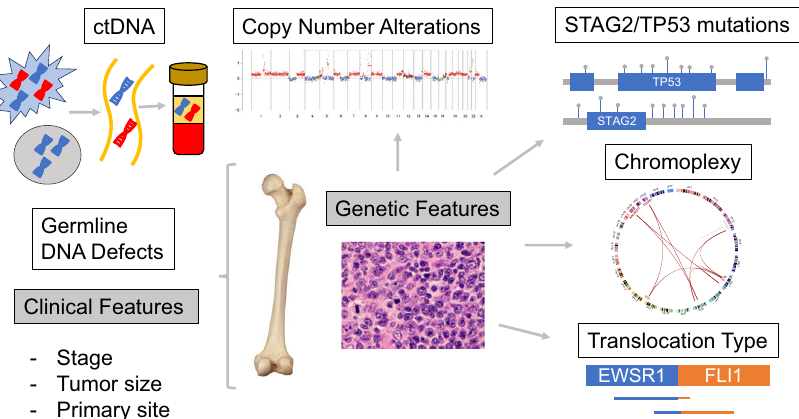
Fig. 1 Schematic representation of potential prognostic biomarkers. In this review we evaluate multiple molecular biomarkers with the potential to inform testing of risk-strati fi ed therapy on a future therapeutic trial. Here we provide a graphical representation of the biomarkers